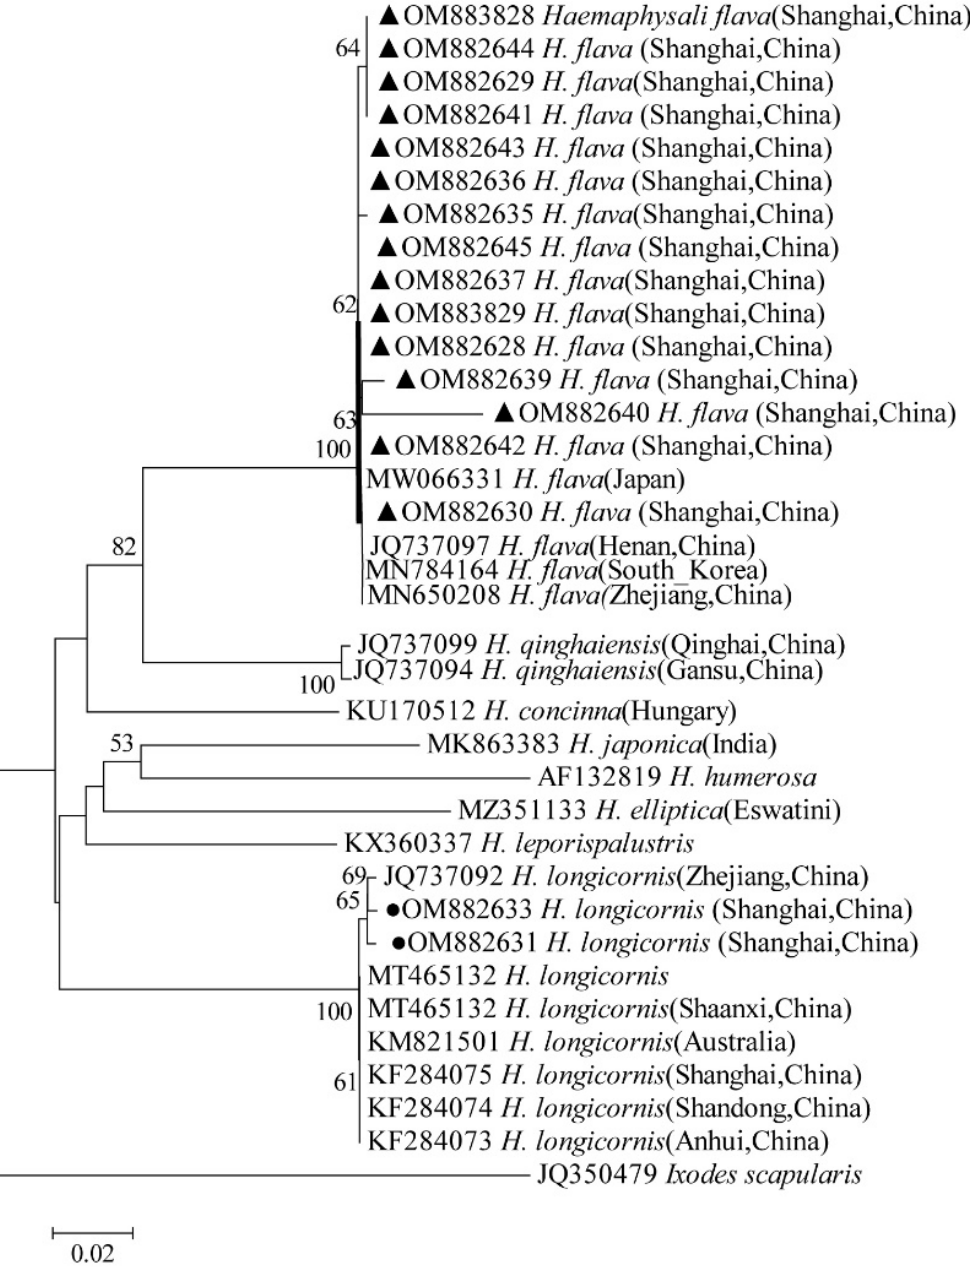
Figure 10. Phylogenetic tree of H. flava and H. longicornis based on partial CO I gene sequence similarity. The sequence from H. flava obtained in this study is indicated with a black triangle, and the sequence from H. longicornis obtained in this study is indicated with black dots. Sequences were aligned using the MEGA X (version 10.0) software package. Phylogenetic analysis was performed by the neighbor-joining method (NJ method), and bootstrap values were estimated for 1000 replicates. Kimura’s two-parameter model was used as a substitution model for the calculation of the phylogenetic trees.